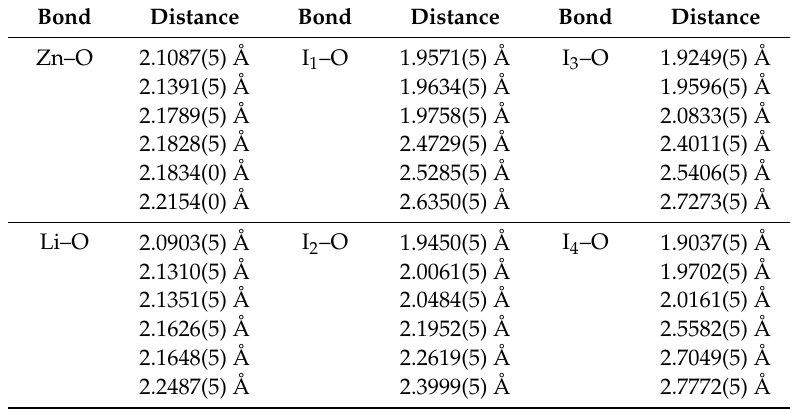
Table2. Zn–O,Li–O,andI–Ointeratomicdistancesinthedi ff erentcoordinationpolyhedraofLiZn(IO 3 ) 3 . Bond Distance Bond Distance